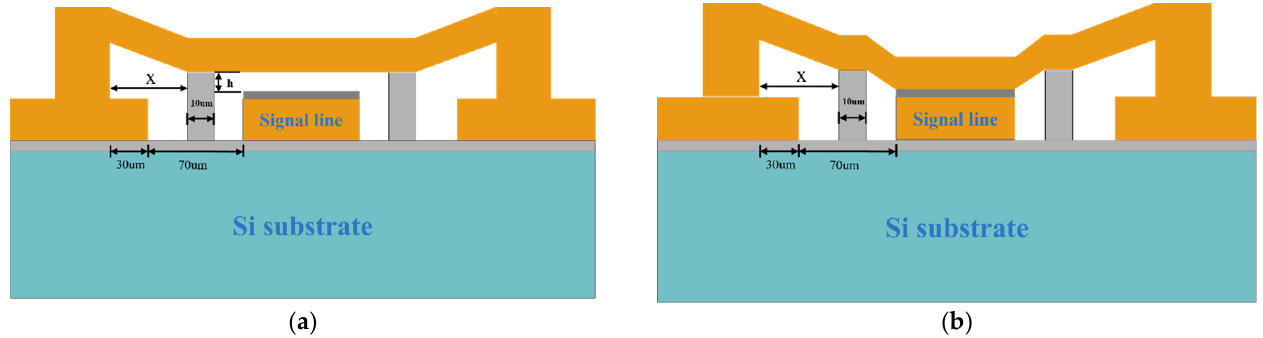
Figure 5. ( a ) MEMS Switch Membrane Equivalent Length Model, ( b ) MEMS Switch Equivalent Pull-in Model.